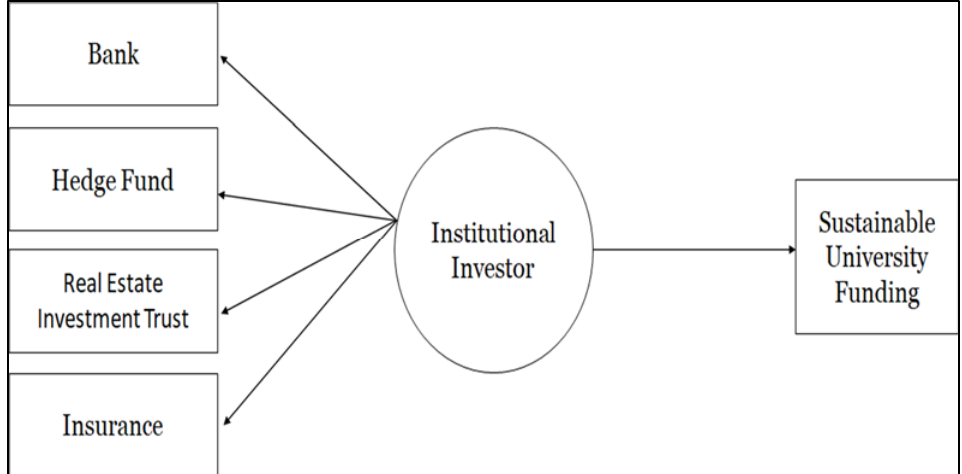
Figure 7. Institutional Investor and University Sustainable Funding.